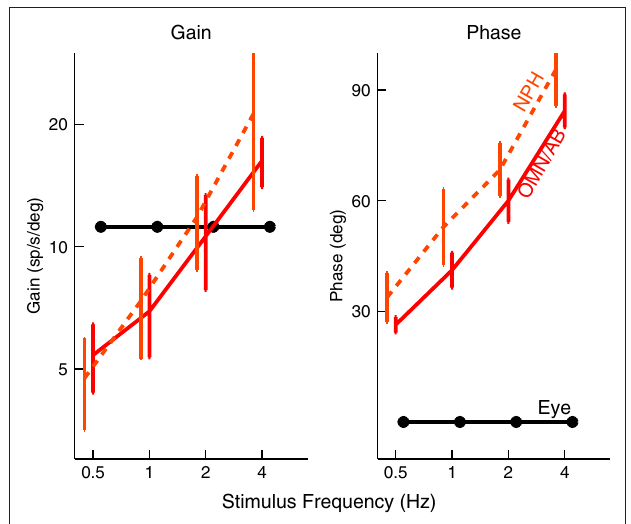
FIGURE 4 | NPH neurons (dashed, orange) behave like the motor command, represented by the solid, red curve. The black lines show the activity of a hypothetical neuron that would encode eye position, with a constant gain and phase. NPH and Ab activity were taken from (Green et al.,